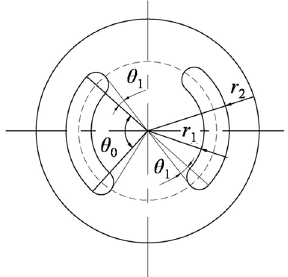
Figure 4. The structures of dynamic and fixed valves.